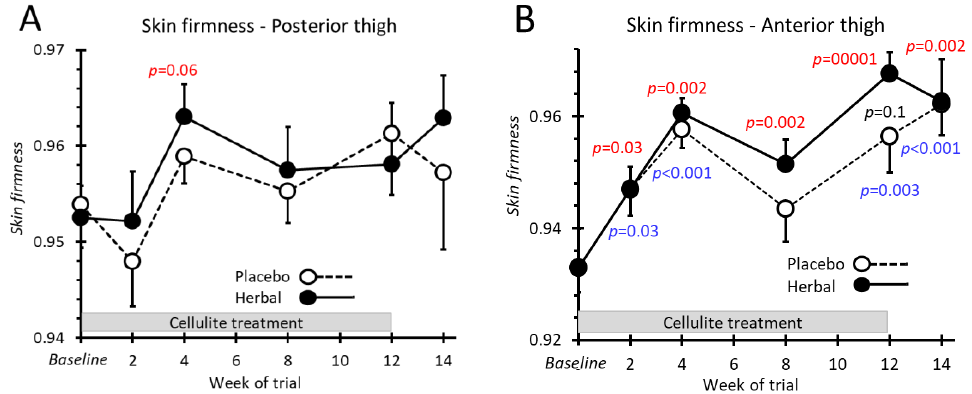
Figure 6. Skin firmness recorded from the posterior ( A ) and anterior ( B ) aspects of the thighs. All p -values colour coded as Figure 4.